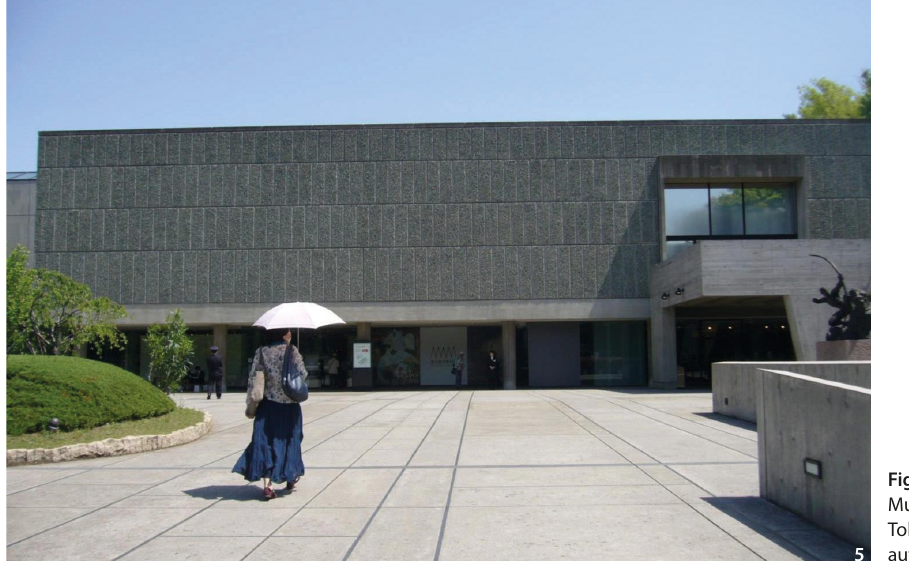
Figure 5 Le Corbusier, the National Museum of Western Art, Uenokoen, Tokyo, Japan, 1959 (Source: the